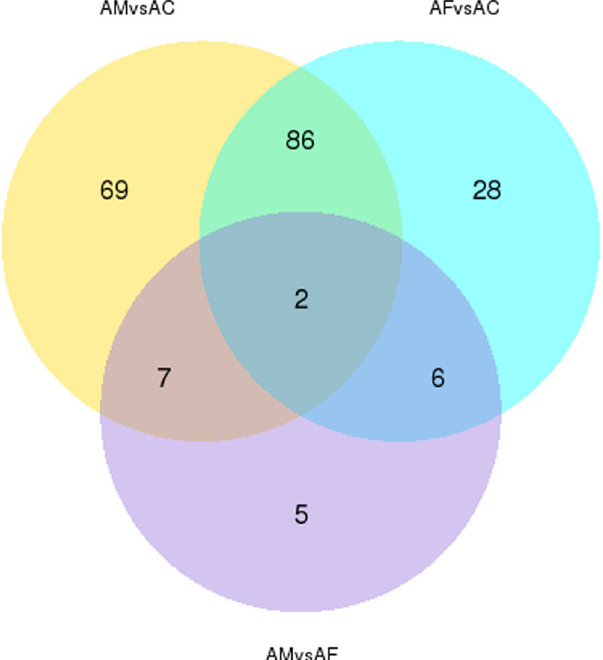
Figure 2. Venn diagram visualizing the number of differential expressed genes for treatments of M . anisopliae (AM), F . axysporum (AF) or control (AC). (The numbers of shared DEGs are indicated in the overlapping parts of the